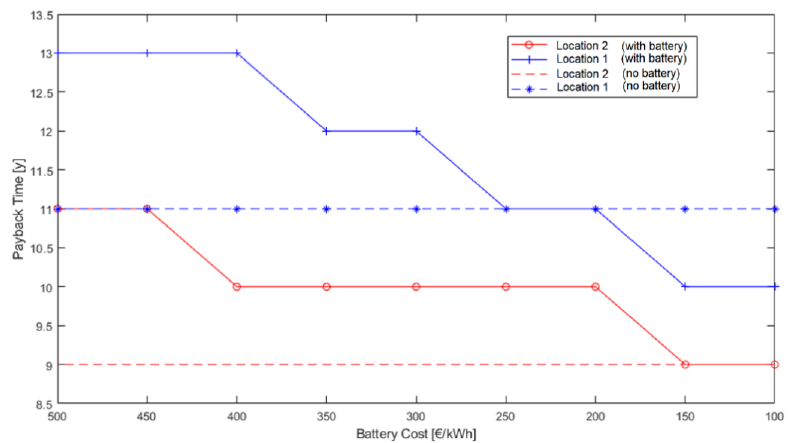
Figure 19. Payback time sensitivity analysis with respect to a variation of the battery cost.